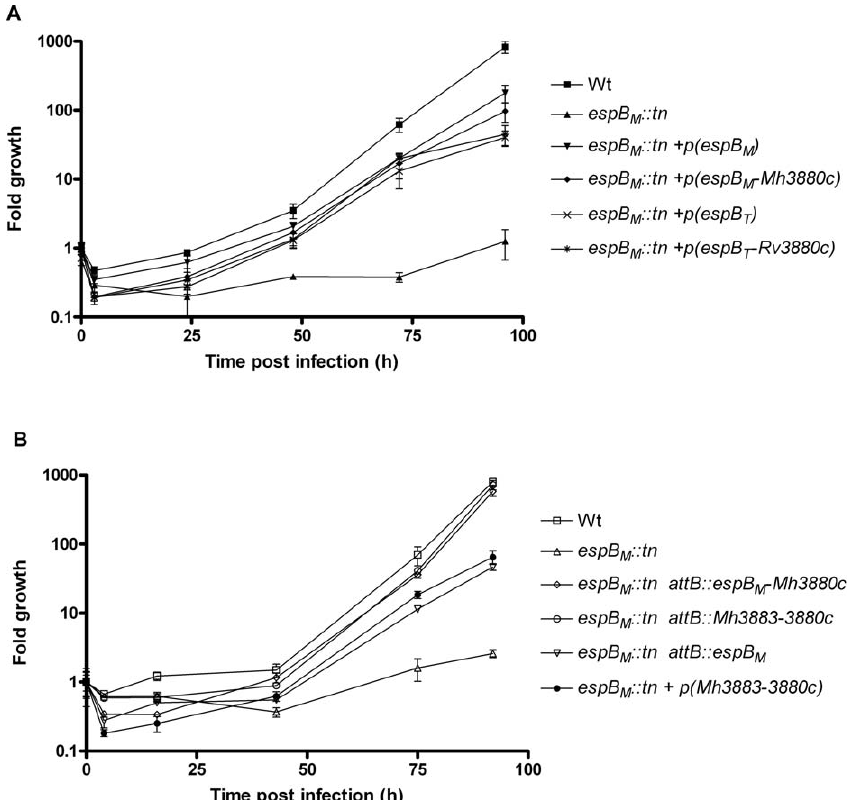
Figure 1. Either EspB T or EspB M Is Sufficient to Restore Growth to the espB M ::tn Mutant in Mouse BMDMs BMDMs were infected at a multiplicity of infection of 1. Colony-forming units (cfu) were determined by lysing infected monolayers and plating lysates at indicated time points. Data were combined for three experiments, with growth indicated as fold increase compared to the initial level of infection for each strain. (A) Wild type (Wt) and espB M ::tn each contain the empty non-integrating plasmid pLYG206; p( espB M ) and p( espB T ) are plasmids for expression of EspB M and EspB T , respectively; and p( espB M -Mh3880c ) and p( espB T -Rv3880c ) encode the second gene of the operon as well as espB for each species. (B) Wild type (Wt) and espB M ::tn each were transformed with the empty integrating plasmid and the indicated genes were integrated into the attB of